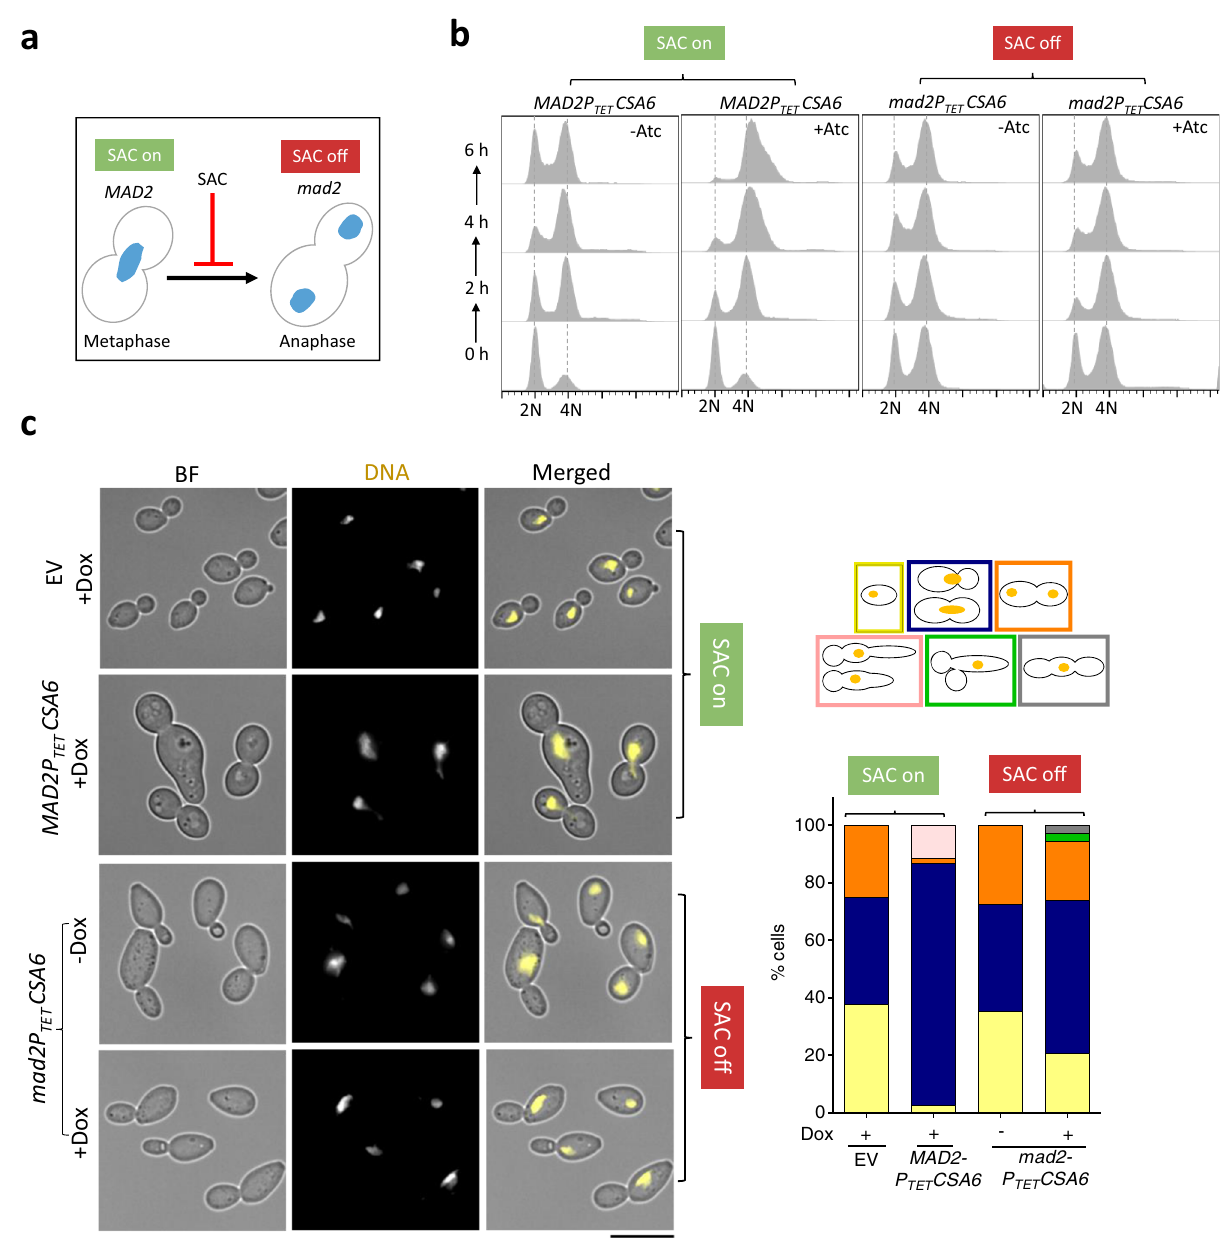
Fig. 4 The G2/M cell cycle arrest in the CSA6 OE mutant is mediated by Mad2. a The G2/M arrest posed by SAC in response to an improper chromosome-spindle attachment is relieved in the absence of Mad2, allowing cells to transit from metaphase to anaphase. b Flow cytometric DNA content analysis in CaPJ176 ( MAD2CSA6 OE ) and CaPJ197 ( mad2CSA6 OE ) at the indicated times, in presence or absence of Atc (3 µ g/ml); N = 3. c Left , microscopic images of CaPJ170 (EV), CaPJ176 ( MAD2CSA6 OE ) and CaPJ197 ( mad2CSA6 OE ) following Hoechst staining, after 8 h of growth under indicated conditions of Dox (50 µ g/ml). Scale bar, 10 µ m. Right , quantitation of the indicated cell types; n ≥ 100